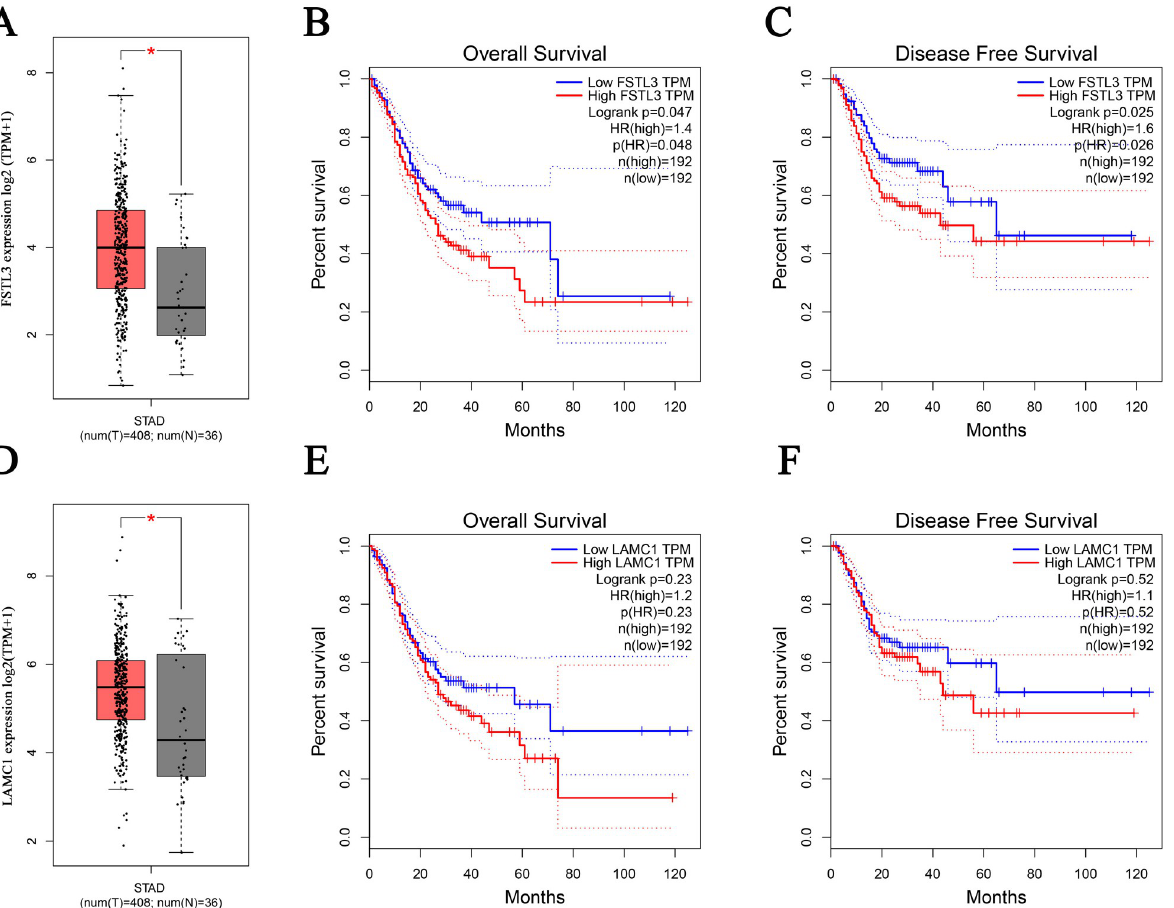
Fig 3. Expression level, overall survival and disease-free survival of FSTL3 and LAMC1 in GC patients from GEPIA. (A) Expression level of FSTL3. (B) Overall survival of FSTL3. (C) Disease-free survival of FSTL3. (D) Expression level of LAMC1. (E) Overall survival of LAMC1. (F) Disease-free survival of